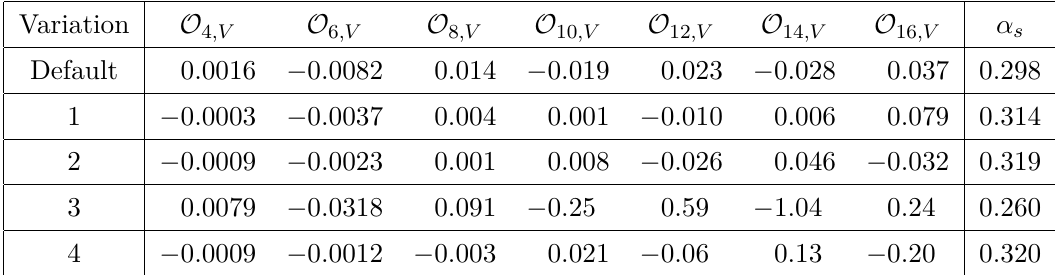
Table 8 . Fitted values of the OPE vector condensates, in GeV units, obtained with the different modifications of the ansatz and FOPT.